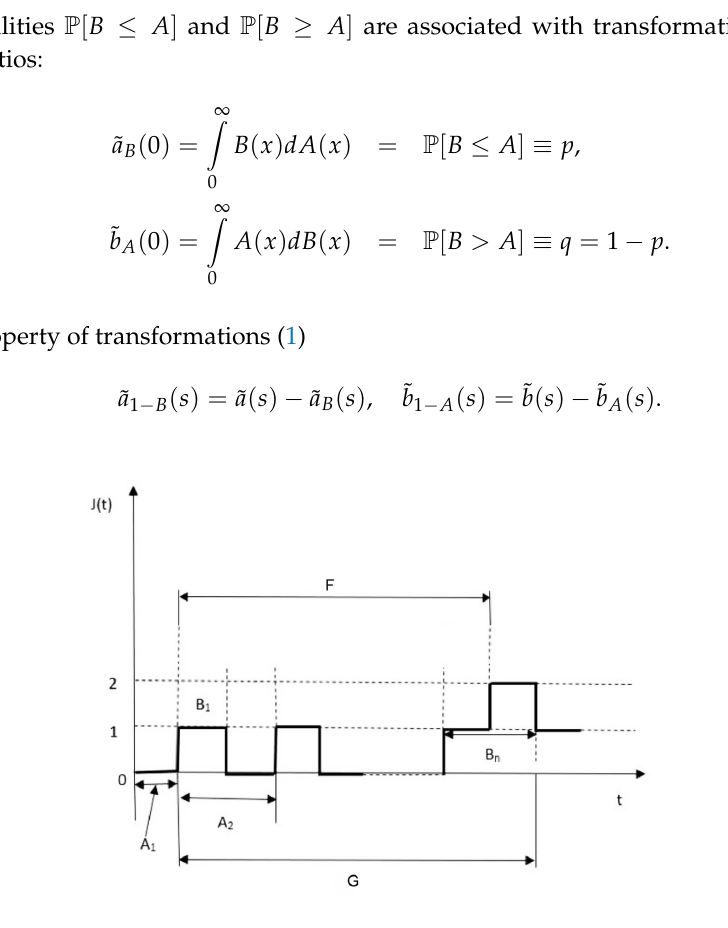
Figure 2. Trajectory of the process J